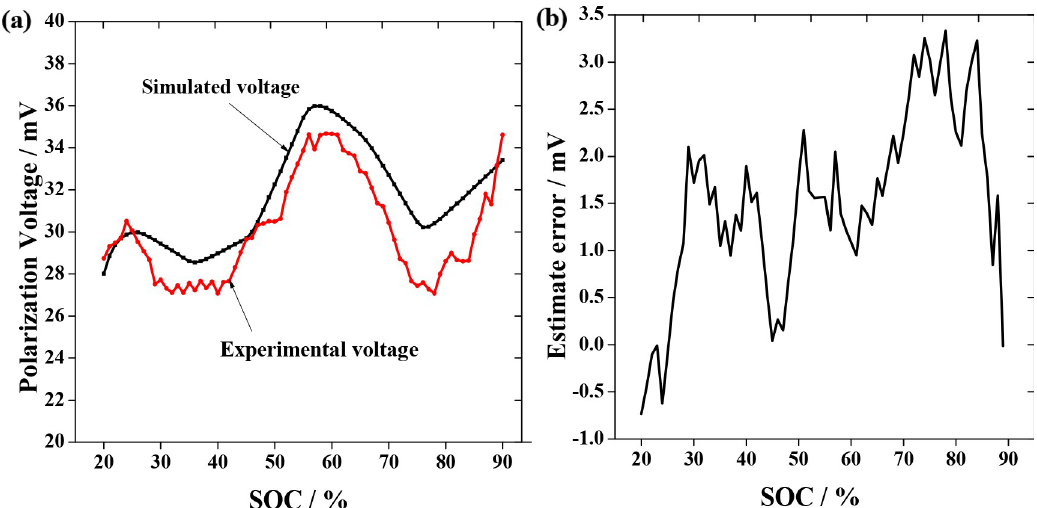
Figure 9. (a) The simulated and measured polarization voltage of the battery for constant charging current; (b) The simulation error for the battery charge polarization